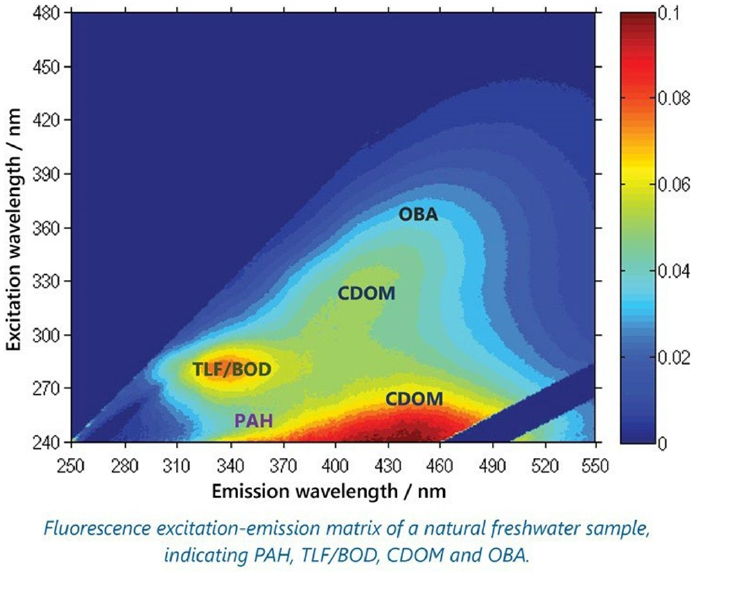
Figure 11. The EEM image for different OMs. Polycyclic aromatic hydrocarbons (PAH), BTEX, CDOM, tryptophan-like fluorescence (TLF), BOD, and optical brightening agents (OBA)